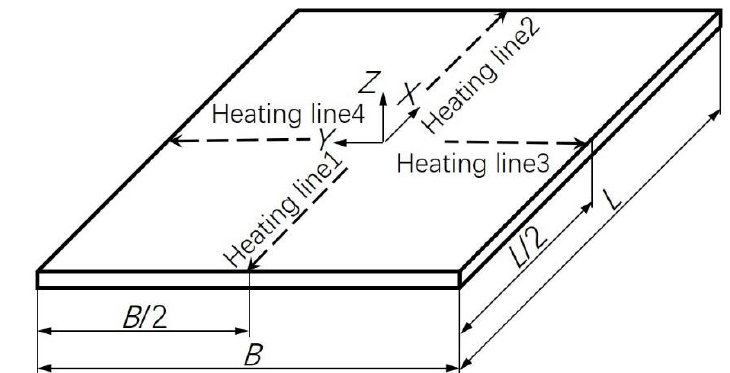
Figure 17 . Heating lines used for pillow-type plates.